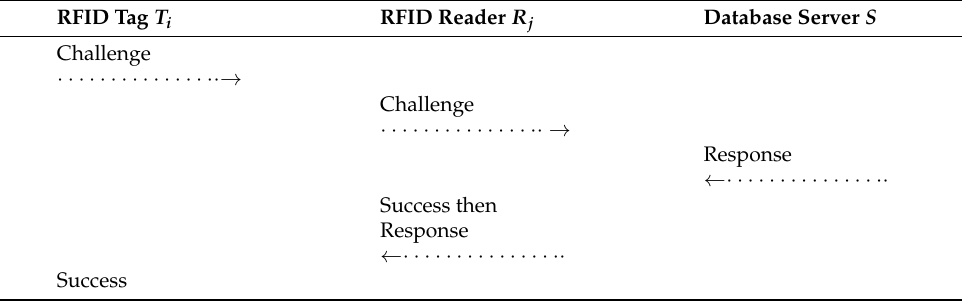
Table 6. Challenge: handshake authentication for the RAFI. RFID Tag T i RFID Reader R